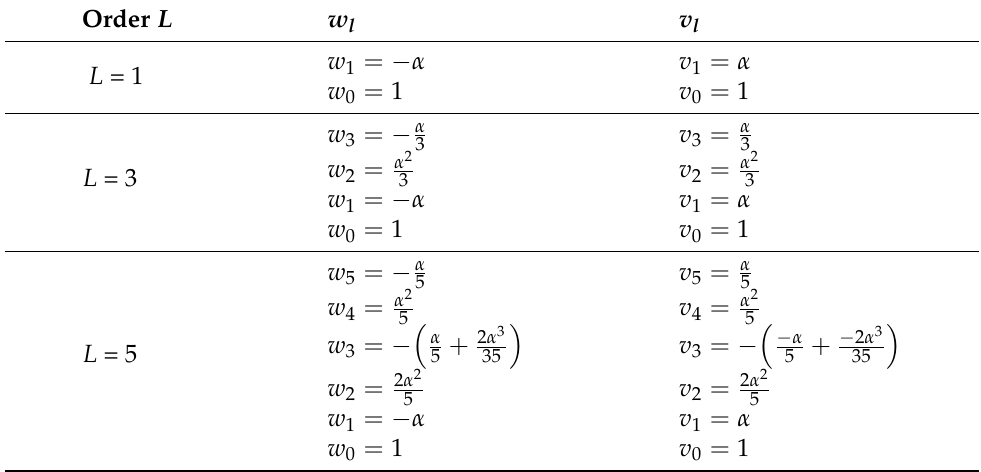
Table 1. Coefficients of CFE polynomials CFE N , D ( z − 1 , α ) for Tustin